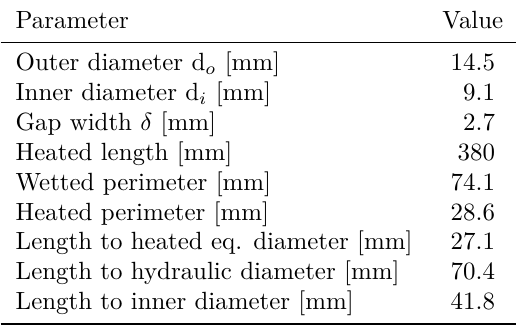
Table 1. The details of test annulus